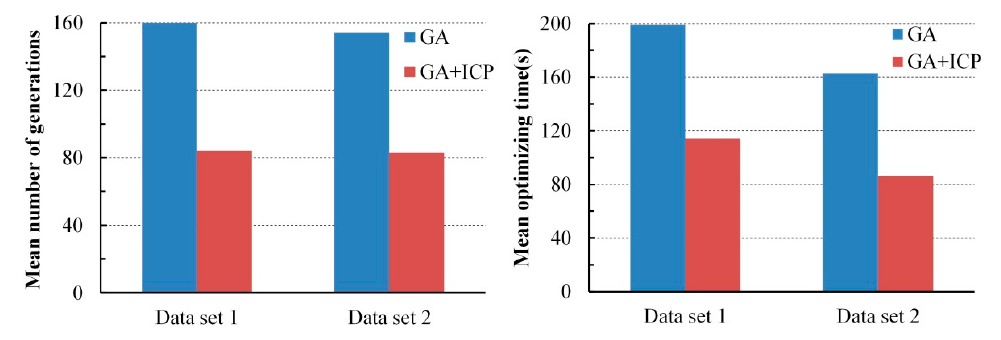
Figure 11. The mean number of generations and optimizing time of GA registration and GA + ICP.